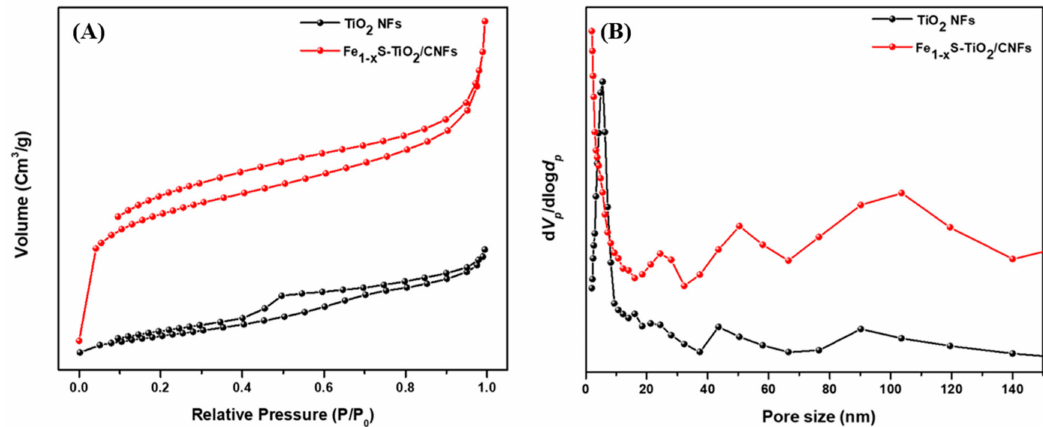
Figure 4. XPS survey ( A ) and high resolution XPS scan for Fe 2p ( B ), S 2p ( C ), Ti 2p ( D ), O 1s ( E ), and C 1s ( F ) of the Fe 1 − x S-TiO 2 / CNFs composite.